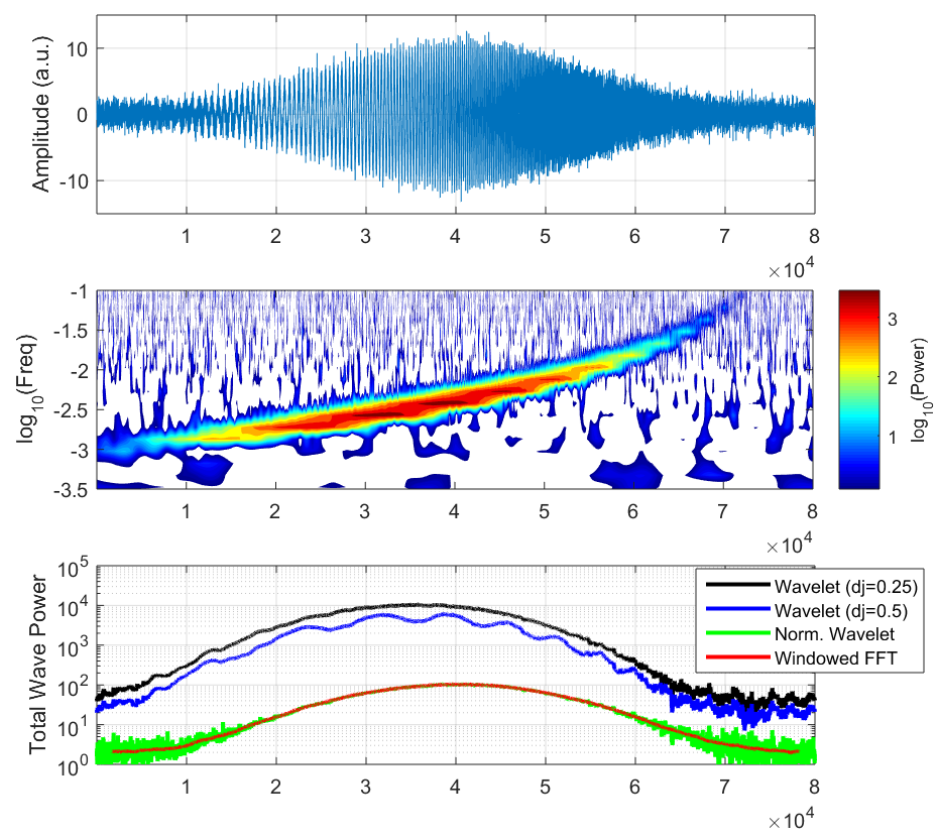
Figure 8. Test signal ( top panel) along with its wavelet time–frequency analysis ( middle panel) and its total power with respect to time ( bottom panel), computed by various